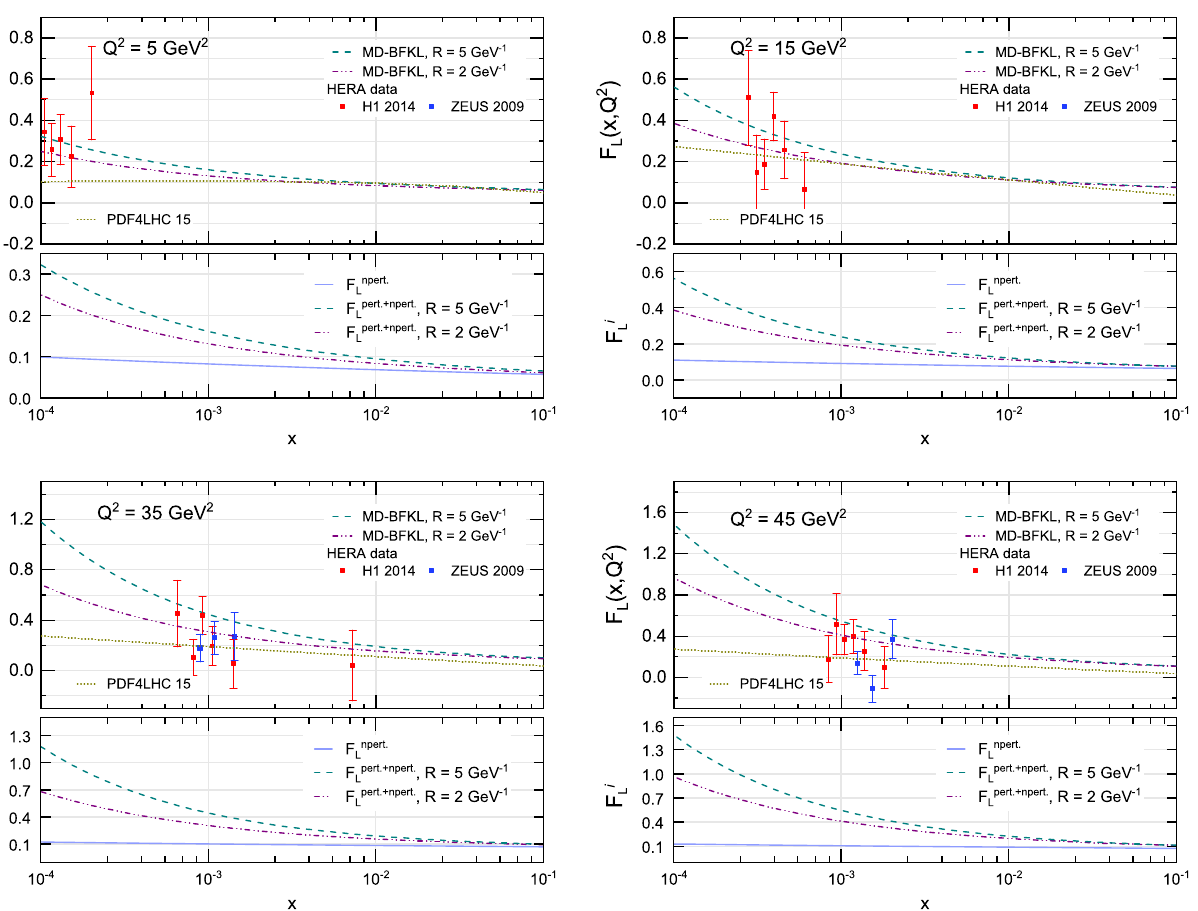
Fig. 15 Prediction for proton structure function F L obtained for two choices of shadowing: conventional ( R = 5 GeV − 1 ) and “hotspot” ( R = 2 GeV − 1 ). Data are taken from HERA H1 [57] and ZEUS [51]. Data-sets from global parametrization group PDF4LHC 15 [54]